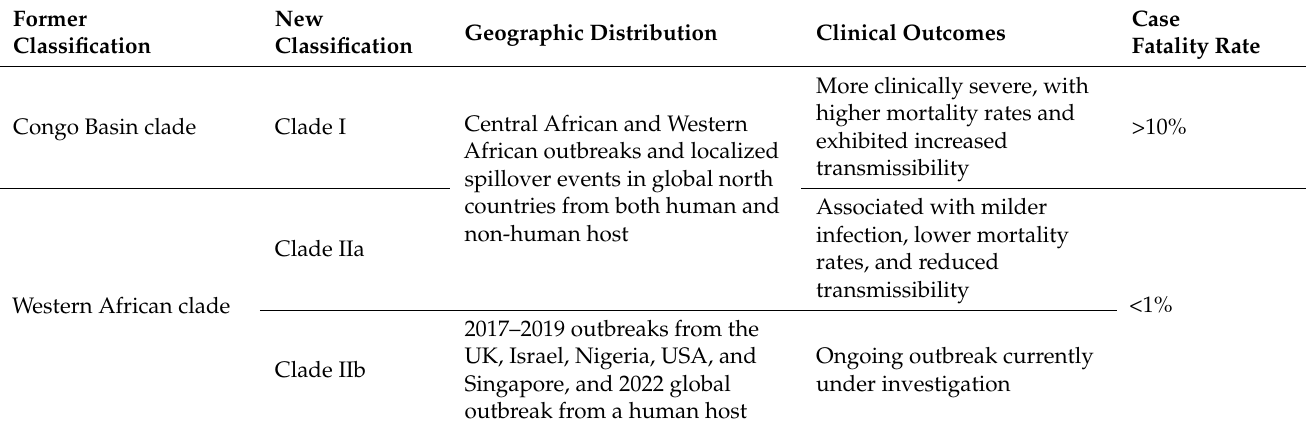
Table 3. Former and new classification of monkeypox virus clades, geographic distribution, clinical outcomes, and case-fatality rates (adapted from